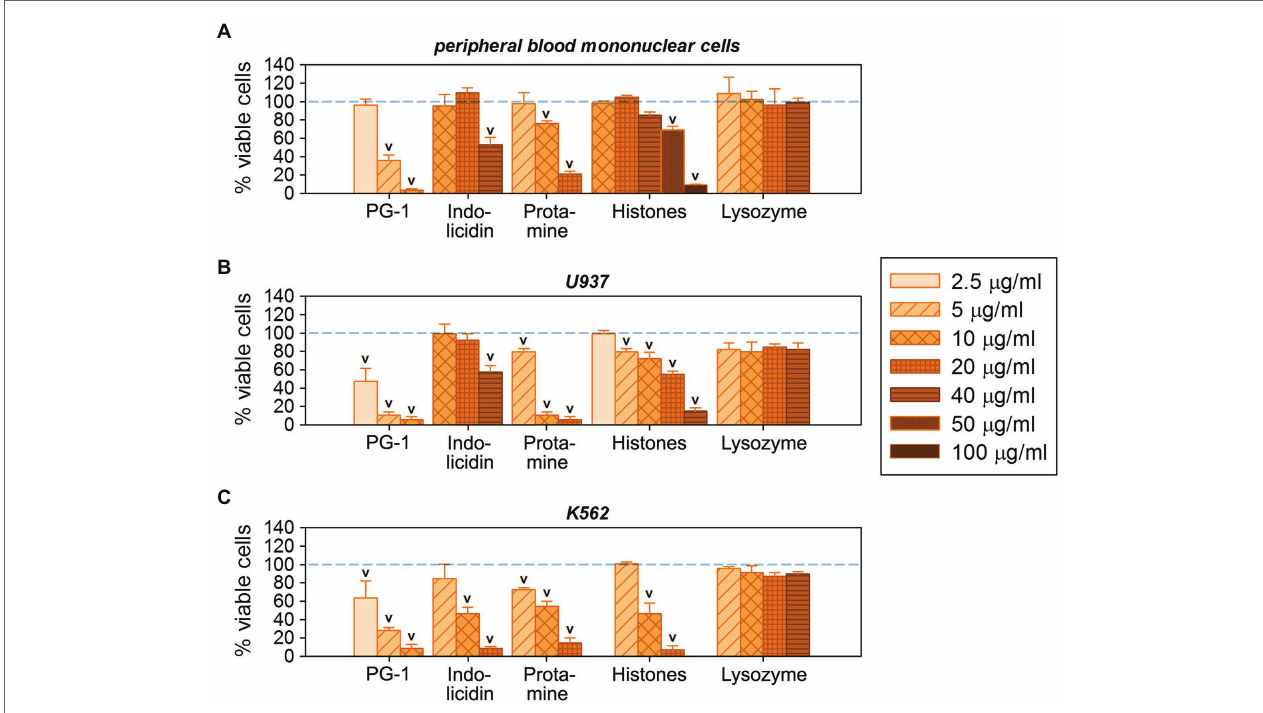
FIGURE 6 | Individual cytotoxic activity of antimicrobial peptides and proteins (AMPs and APs) used for conjugation on eukaryotic cells: on normal human peripheral blood mononuclear cells (A) , as well as on human cancer cell lines U937 (B) and K562 (C) . Mean ± standard deviation values were calculated based on three independent MTT-tests performed in triplicate. Cases of statistically significant toxic effect in comparison with non-treated control (100% viable cells) are denoted with V (Mann–Whitney U-test, p <